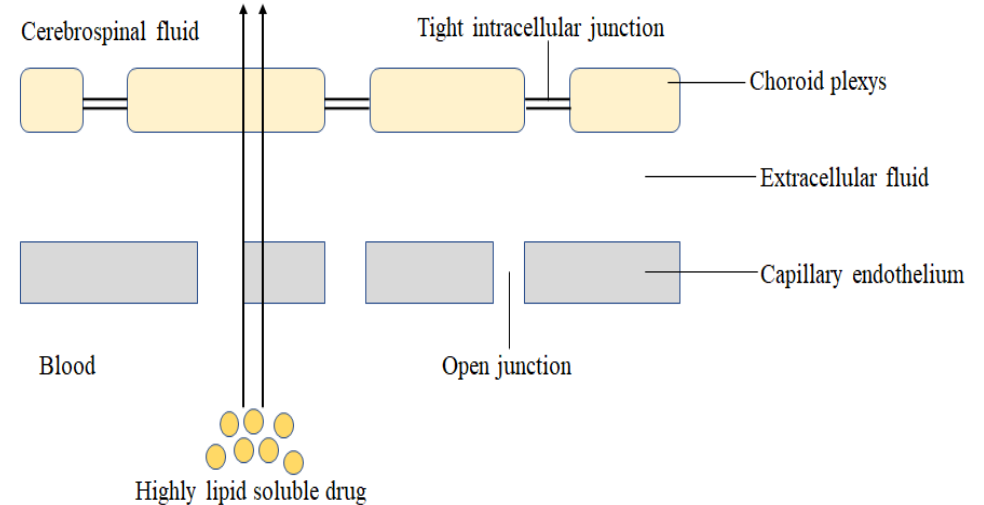
Fig. 2. Blood cerebrospinal fluid